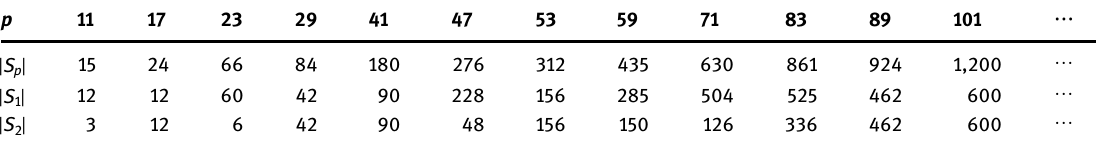
Table 2: Values of ∣ ∣ S p , ∣ ∣ S 1 , and ∣ ∣ S